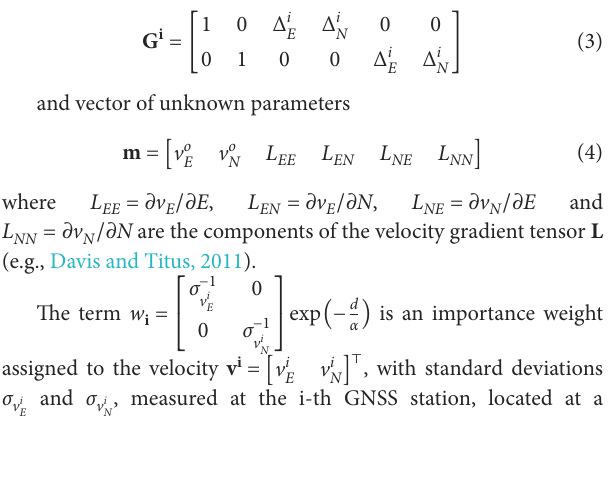
interseismic period, and the effects of the 2014 earthquake are only visible as lower magnitude velocities near the rupture zone